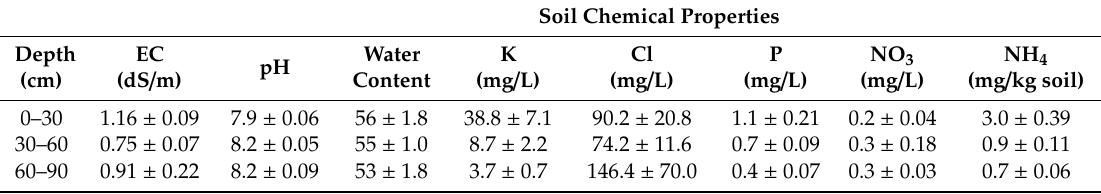
Table 1. Soil chemical properties (mean and standard errors) before treatment application.